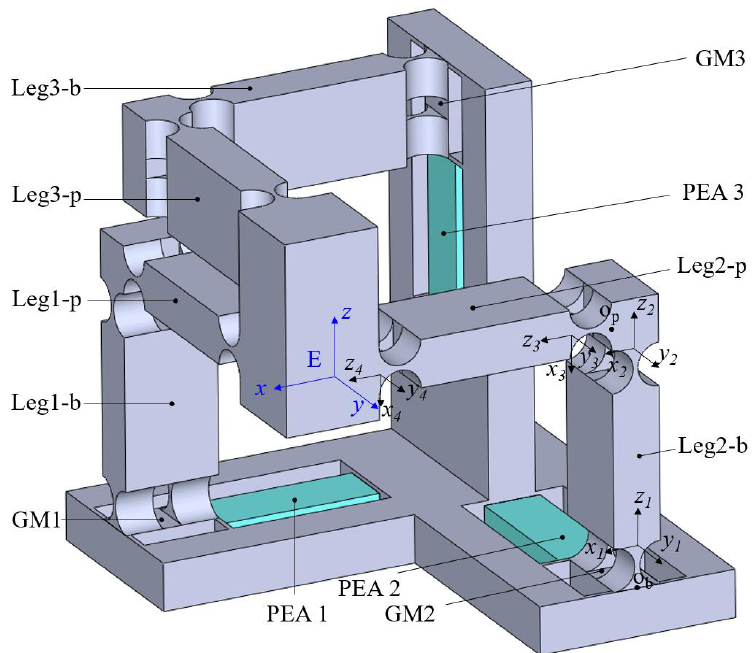
Figure 2. Mechanical structure of the proposed triaxial compliant